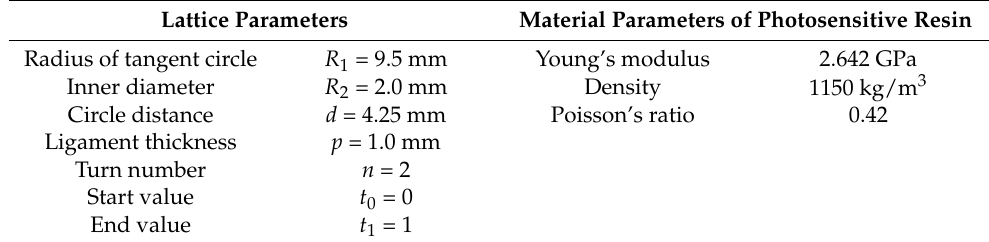
Table 2. Geometry and material parameters of the structure. Lattice Parameters Material Parameters of Photosensitive Resin